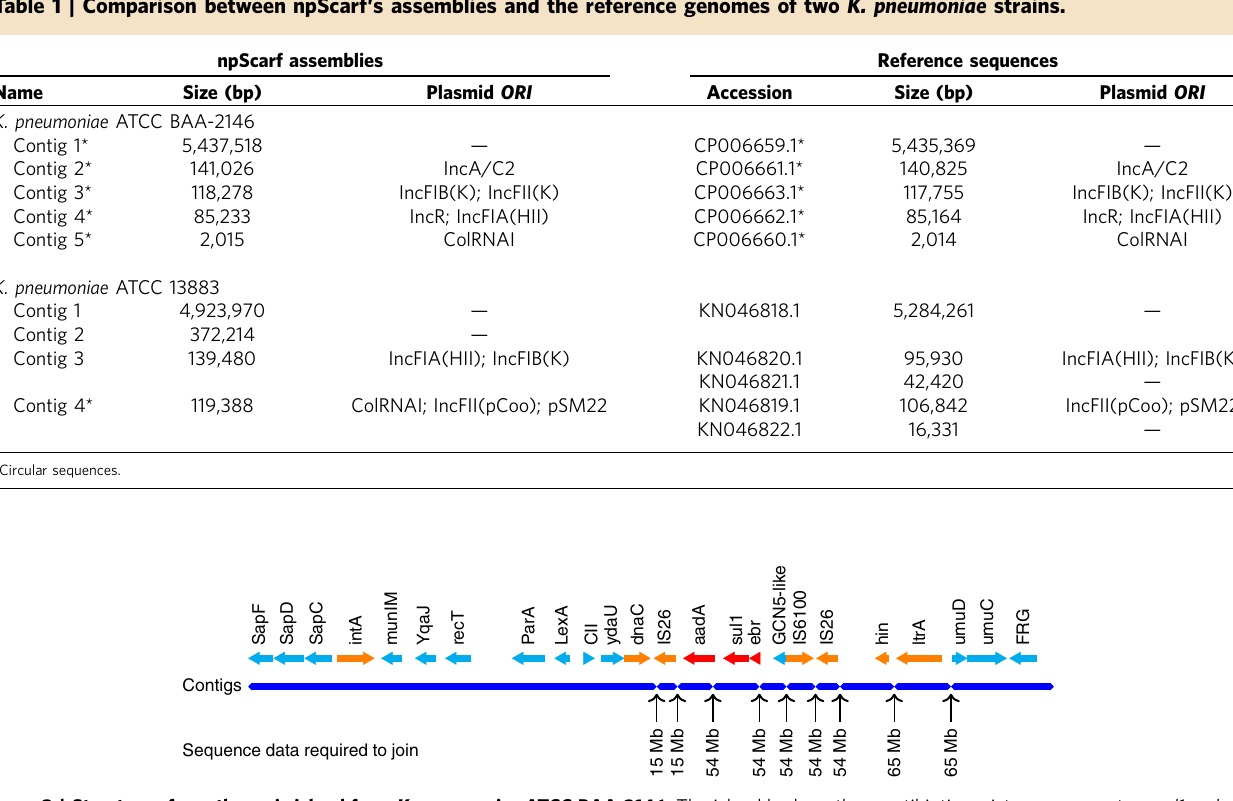
Figure 3 | Structure of a pathogenic island from K. pneumoniae ATCC BAA-2146. The island harbors three antibiotic resistance genes strep , sul1 and ebr , flanked by mobility genes integrase ( int ), inverstase ( hin ), DNA replication ( dnaC ) and IS (IS26 and IS6100). The island was fragmented into 10 contigs in the Illumina assembly, and was completely resolved with 65Mb out of the total of 185Mb of nanopore sequence